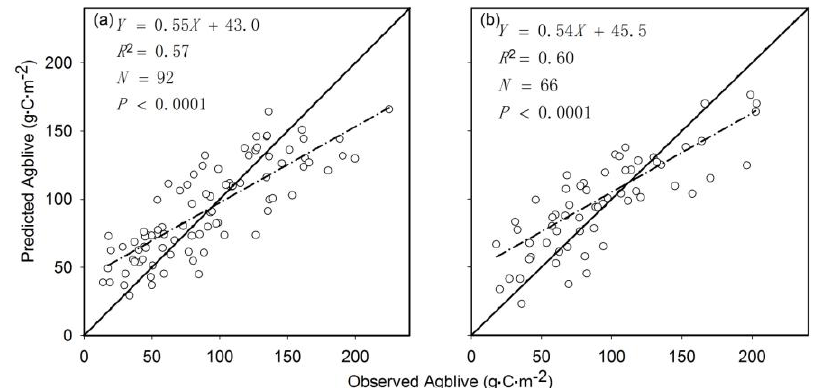
Figure 2. Comparison of the predicted and observed aboveground live biomass carbon density (Agblive) at calibration ( a ) and validation ( b ) sites. The solid line is the 1:1 line and the short dashed line is the linear regression